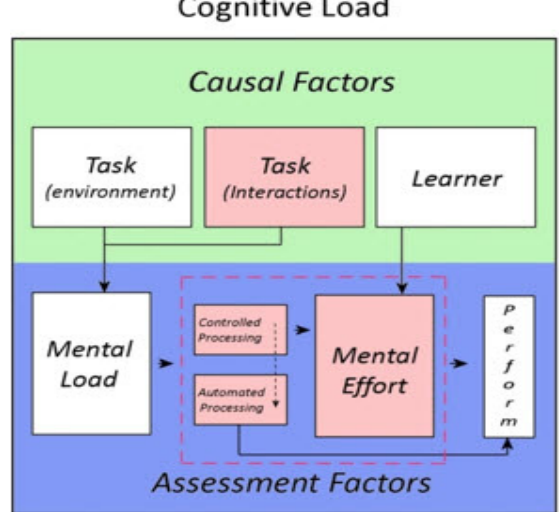
Figure 1. Cognitive Load Schematic adapted from Paas & Merrienboer,